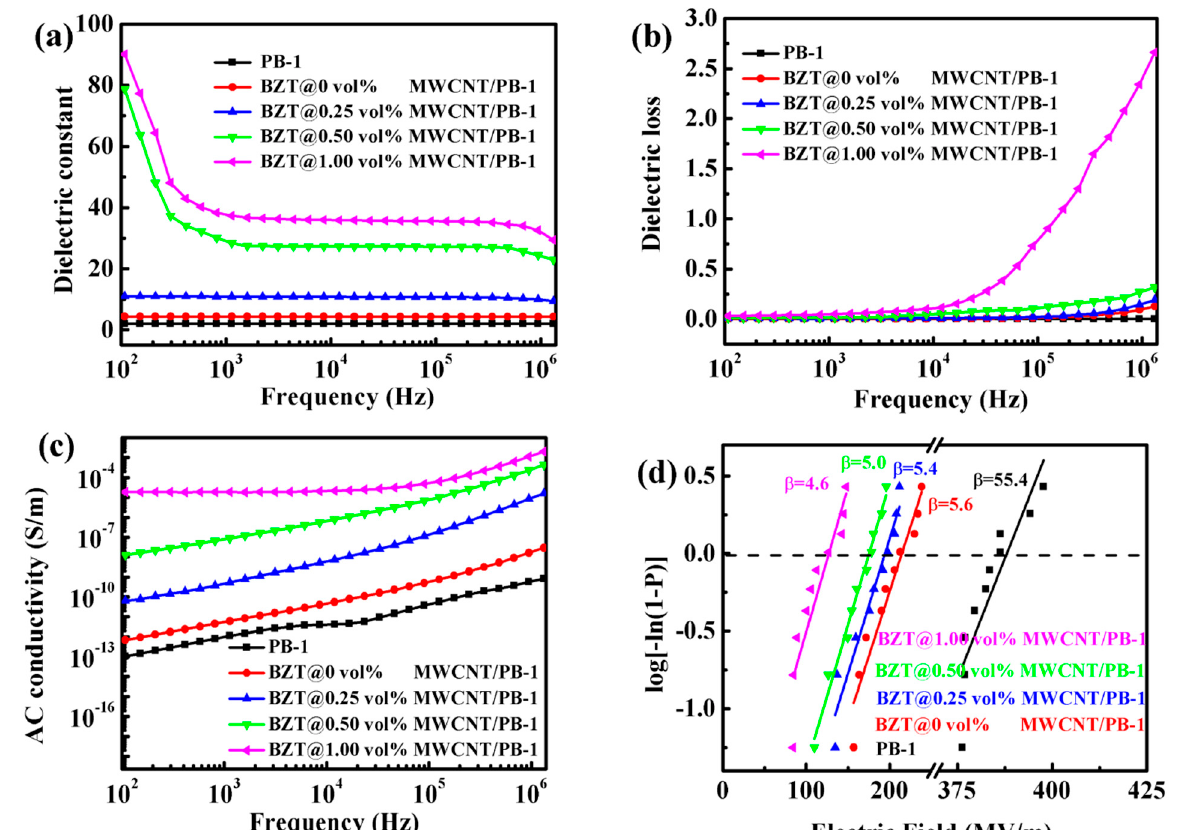
Figure 7. Variation in ( a ) dielectric constant, ( b ) dielectric loss, and ( c ) AC conductivity with frequency shown by the 10 vol% BZT@MWCNTs/PB-1 composite films with different MWCNTs contents at room temperature. ( d ) Effects of the addition of different MWCNTs contents to 10 vol% BZT on the breakdown performance of the composite films.